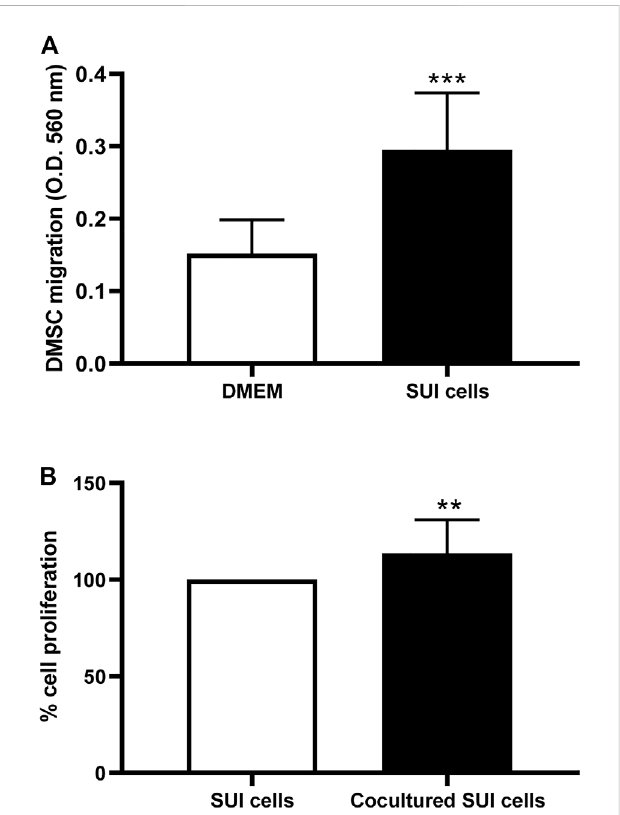
FIGURE 5 Co-culture of DMSC and SUI myo fi broblasts has effects on the behaviorofbothcelltypes. (A) Invitro transwellmigrationassayofDMSC toward suburethral myo fi broblasts or culture medium. Suburethral myo fi broblasts enhanced the migration ability of DMSC in vitro . Data is expressed as mean ± SD, n = 5 in duplicate, *** p < .001. (B) Proliferation of suburethral myo fi broblasts was determined by Presto blue assay after co-culture with DMSC seeded on Transwell ® culture inserts. DMSC enhanced the proliferation of suburethral myo fi broblast in vitro . The cells analyzed correspond to passages 5 – 6. Data is expressed as Mean ± SD, n = 5, ** p < .01.